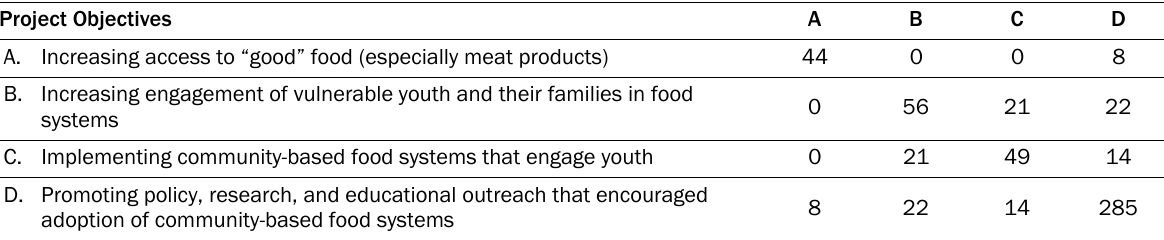
Table 5. Affiliation Matrix of 2011 Project Component